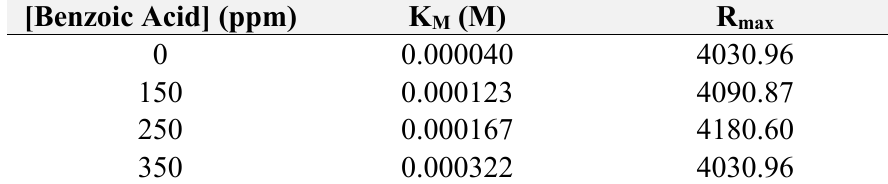
) in various concentrations of benzoic acid. M